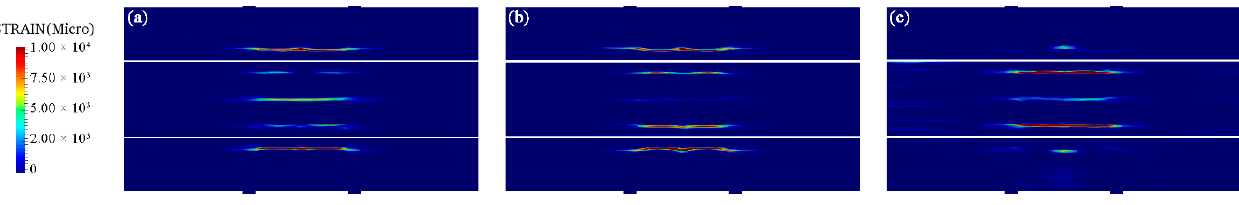
Figure 11. The corrosion-induced strain on the beam surface under different loading conditions (serviceability limit state): ( a ) S-L00, ( b ) S-L30, and ( c ) S-L60.